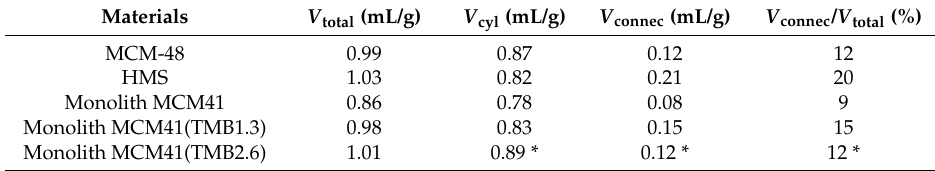
Table 2. Cylindrical and connection pores volumes of MCM-41-like Monoliths and as comparison of MCM-48 and HMS ordered mesoporous